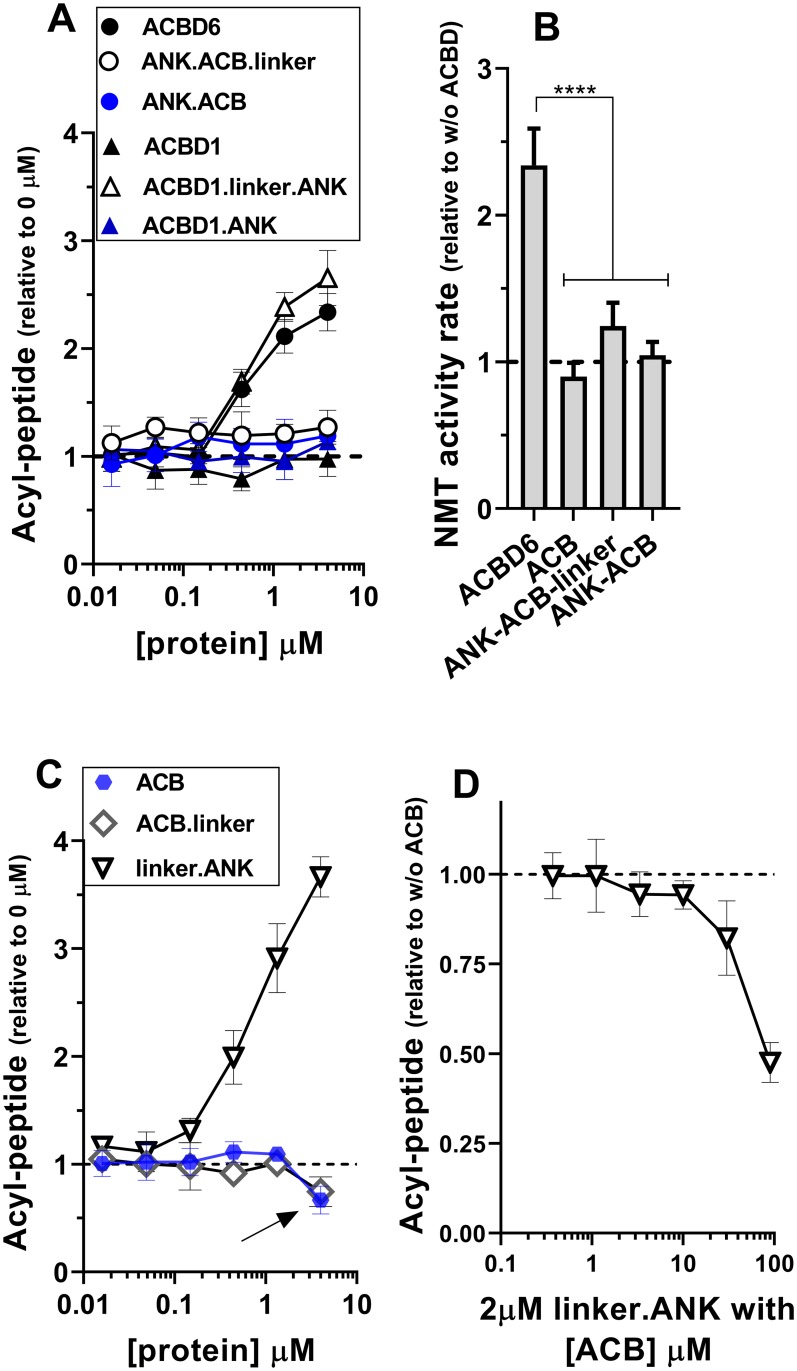
Role of the ACB domain and linker region in NMT2 activity.Formation of the myristoyl-peptide by NMT2 was measured in the presence of the indicated proteins over a concentration range of 0.016 to 4μM (panel A and C) and with 2μM of the linker.ANK form in the presence of increasing concentration of the ACB form (0.4 to 90μM) (panel D). Activity of NMT2 was measured in the presence of 4μM of the indicated proteins from 0 to 8 min and the rates of formation of the acyl-peptide are reported relative to the values obtained in their absence (panel B). Control reactions were performed in the absence of the ACBD constructs (panel A, C) and in the absence of ACB (panel D). The data are presented relative to the values obtained in their absence. The decrease in acyl-peptide formation in the presence of the ACB and ACB.linker forms observed at 4μM is indicated with an arrow in panel C. Human NMT2 enzyme was added at a concentration of 50nM in the presence of 5μM C14-CoA. Error bars represent the standard deviations of values obtained from three reactions. **** indicate a p value of <0.0001.